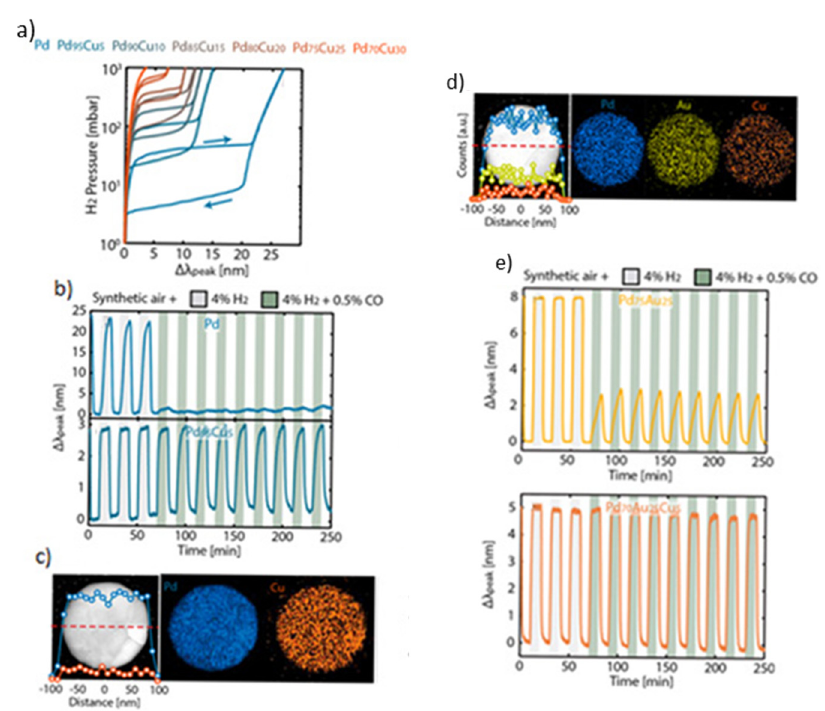
Figure 7. ( a ) Optical response of INP-base material with PdCu alloy nanoparticles when exposed at pressures between 1 and 10 3 mbar (10 2 to 10 5 Pa). The right and left arrows indicate the absorption and desorption part of the cycle. ( b ) Hydrogenation/dehydrogenation cycling in Pd and Pd 95 Cu 5 . In both cases, the first three gray-shaded areas correspond to 10-min exposure periods of the sensing material to 4% H 2 . In the remaining nine green-shaded periods, the sensing material was exposed to a gas consisting of 4% H 2 + 0.5% CO at ambient pressure. ( c ) STM image and its corresponding EDS line-scan (red dashed line; left), and elemental mapping (right) of a Pd 85 Cu 15 nanodisc. The blue data points (left) and mapping (right) correspond to the fraction of Pd of the nanodisc, while the orange points (left) and mapping (right) represent the Cu fraction of the nanodisc. ( d ) STM image of a Pd 70 Au 25 Cu 5 nanodisc (left) and the corresponding EDS elemental mapping (right). The blue data points (left) and mapping (right) correspond to the fraction of Pd, the yellow points (left) and mapping (right) to the Au fraction, and the orange points (left) and mapping (right) to the Cu fraction. ( e ) Hydrogenation/dehydrogenation cycling in Pd 75 Au 25 and Pd 70 Au 25 Cu 5 . In both cases, the first three gray-shaded areas represent the periods when the materials were exposed to synthetic air containing 4% H 2 . The remaining 9 areas correspond to periods when the material was exposed to synthetic air containing 4% H 2 and 0.5% CO. Adapted from [79], with permission from ACS Publications, 2019.